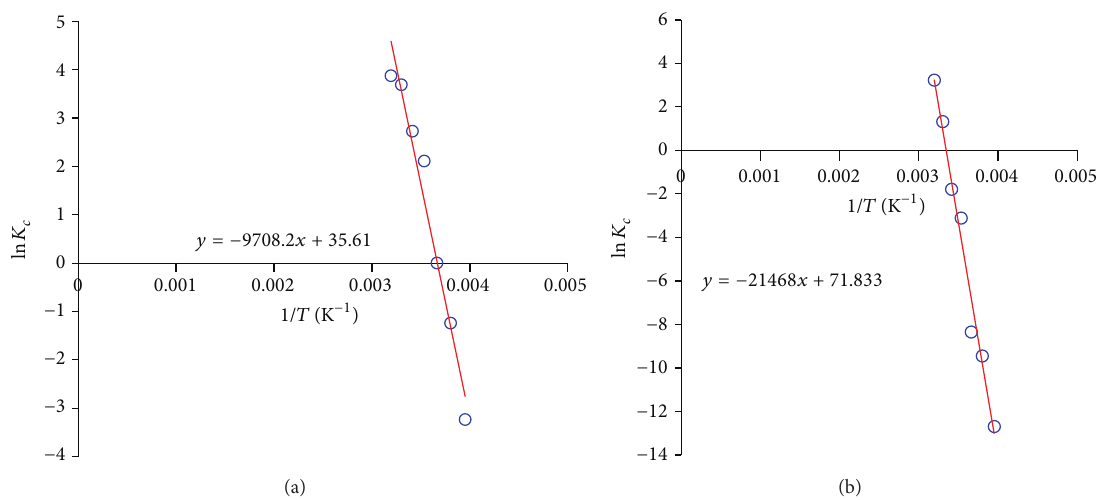
Figure 13: Determination of the heat of adsorption at (a) CO 2 flow rate = 0.3 L/min, %RH = 20%, and initial CO 2 concentration = 365 ppm and (b) CO 2 flow rate = 0.3 L/min, %RH = 80%, and initial CO 2 concentration = 365